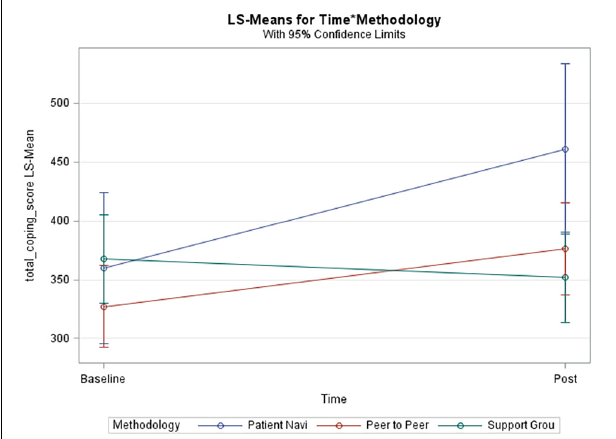
FIGURE 2 | Unadjusted model of total coping score. Blue line (Patient Navi), patient navigator methodology; Red line (Peer to Peer), peer-to-peer methodology; Green line (Support Grou), support group methodology.